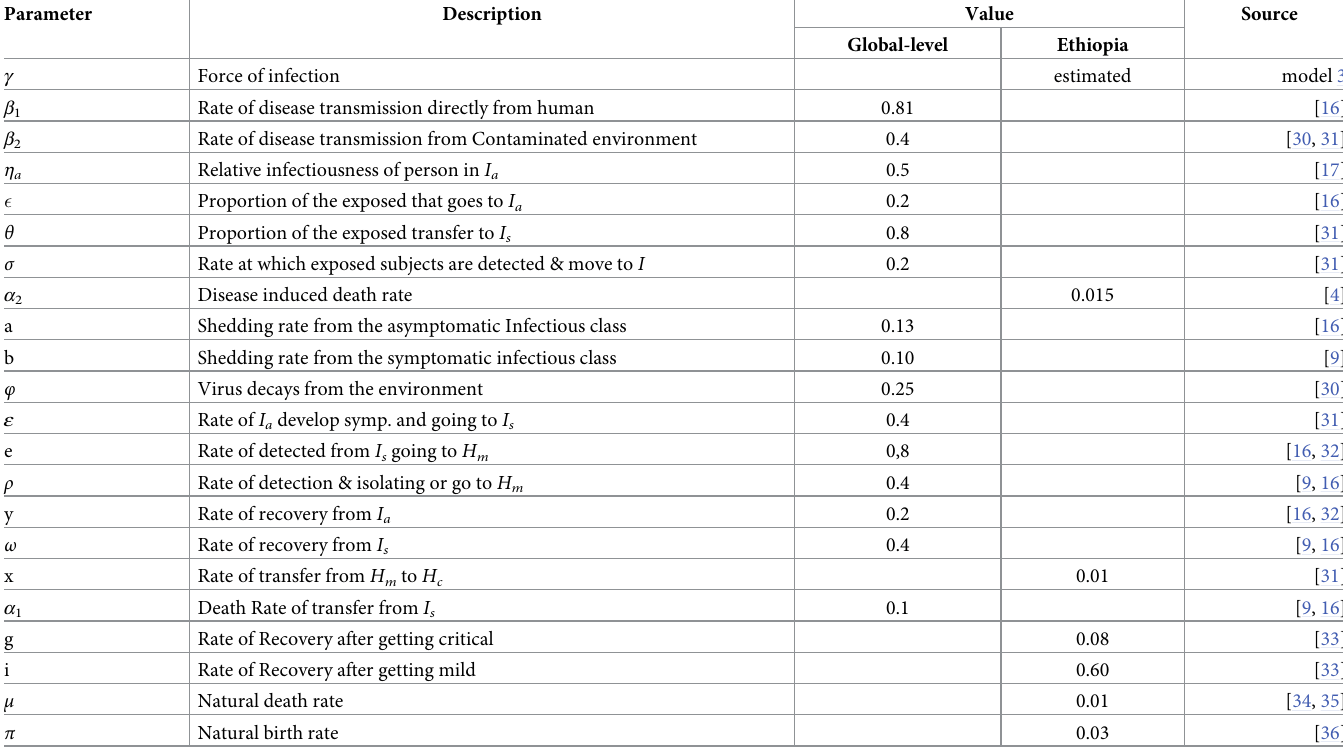
Table 1. Description and values of initial model (1) parameters. Parameter estimates were obtained from previous